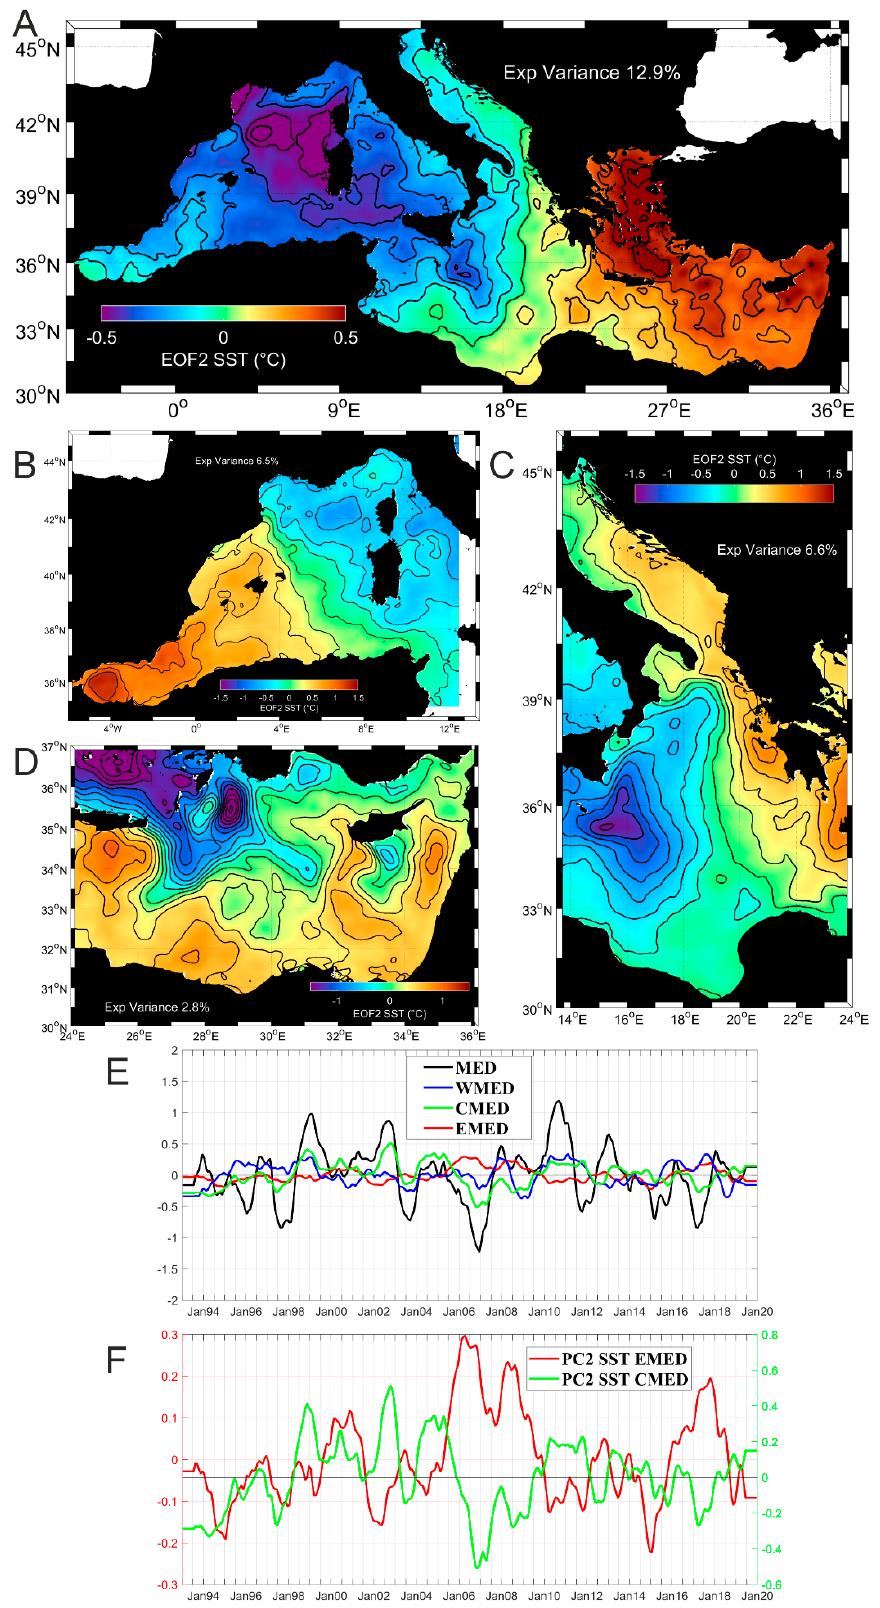
Figure 7. EOF2 of the SST for the MED ( A ), WMED ( B ), CMED ( C ), and EMED ( D ), and relative PC2s ( E ); zoom on the PC2 of the CMED and EMED ( F ).